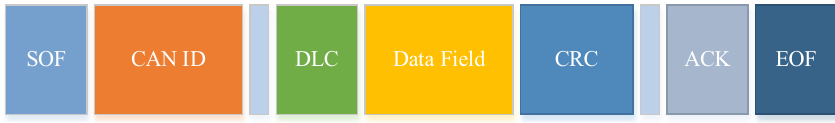
Figure 4. CAN data frame structure, where SOF represents Start of Frame, DLC represents Data Length Code, CRC represents Cyclic Redundancy Check, ACK represents Acknowledgement, and EOF represents End of